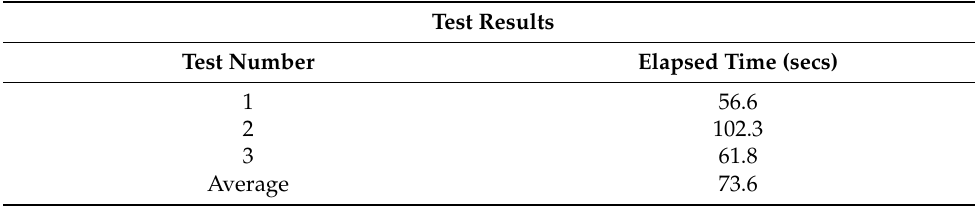
Table 1. IoT device redeployment duration.